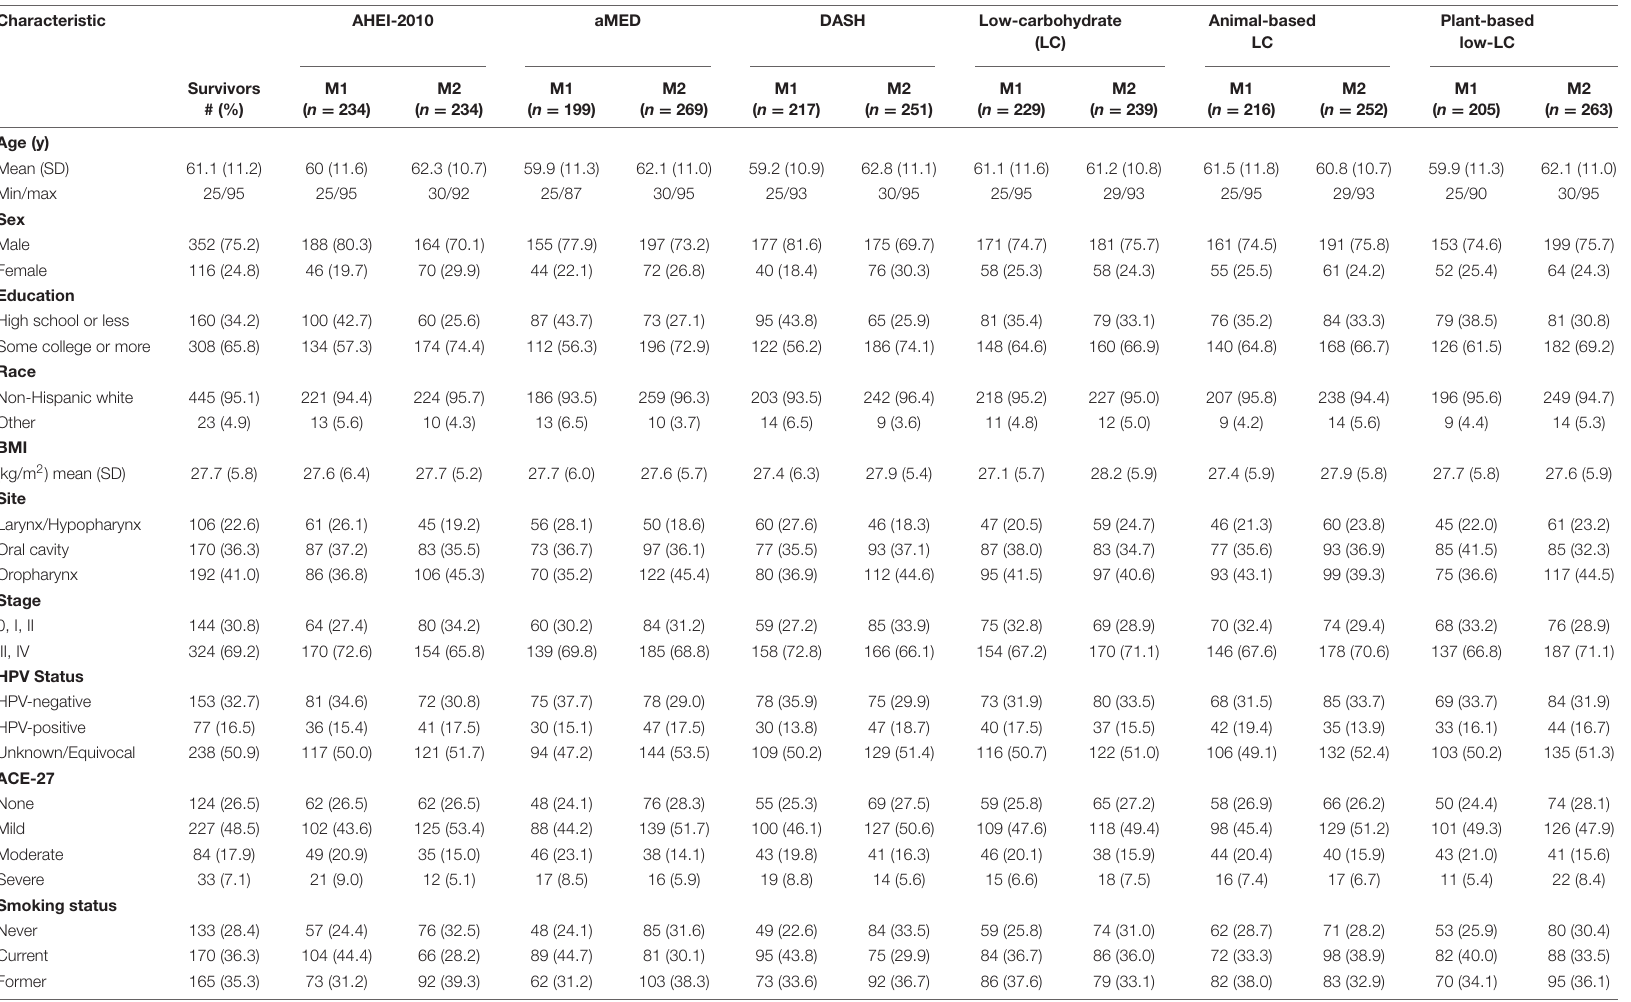
TABLE 1 | Demographic, clinical, and behavioral baseline characteristics of the study participants in the overall study sample ( n = 468) and across high and low scores (split at the median) of the diet quality indices.